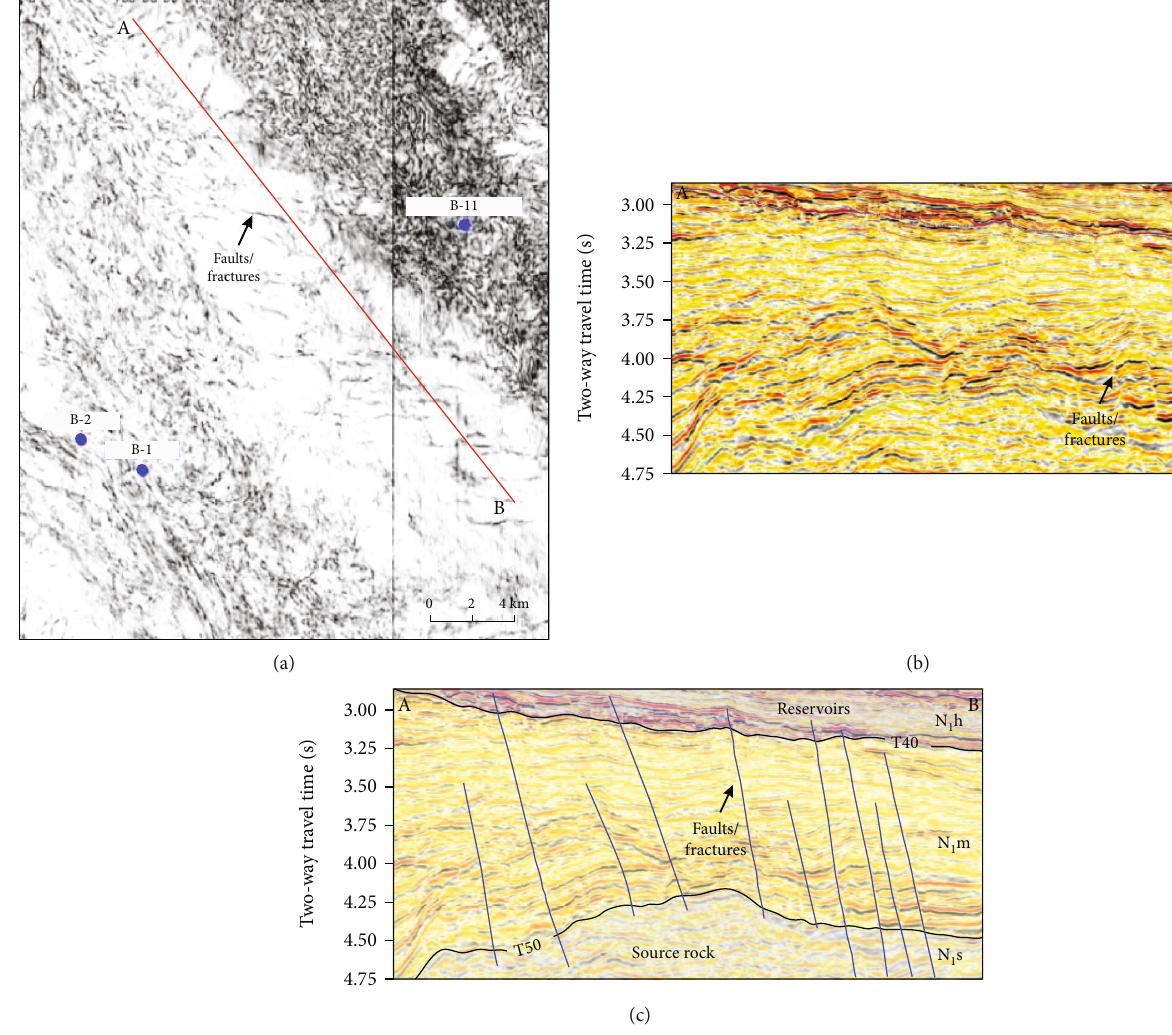
Figure 11: (a) Variance slices of the Ledong Slope in the Yinggehai Basin (4250ms), note that these extensional faults are primarily oriented E-W, (b) seismic section in two-way travel time showing series of hidden faults or microfractures, and (c) interpretation of the seismic section showing the source rock and (Figure 10), which further con fi rms that ultradeep buried source rocks have the potential for overpressure transfer.